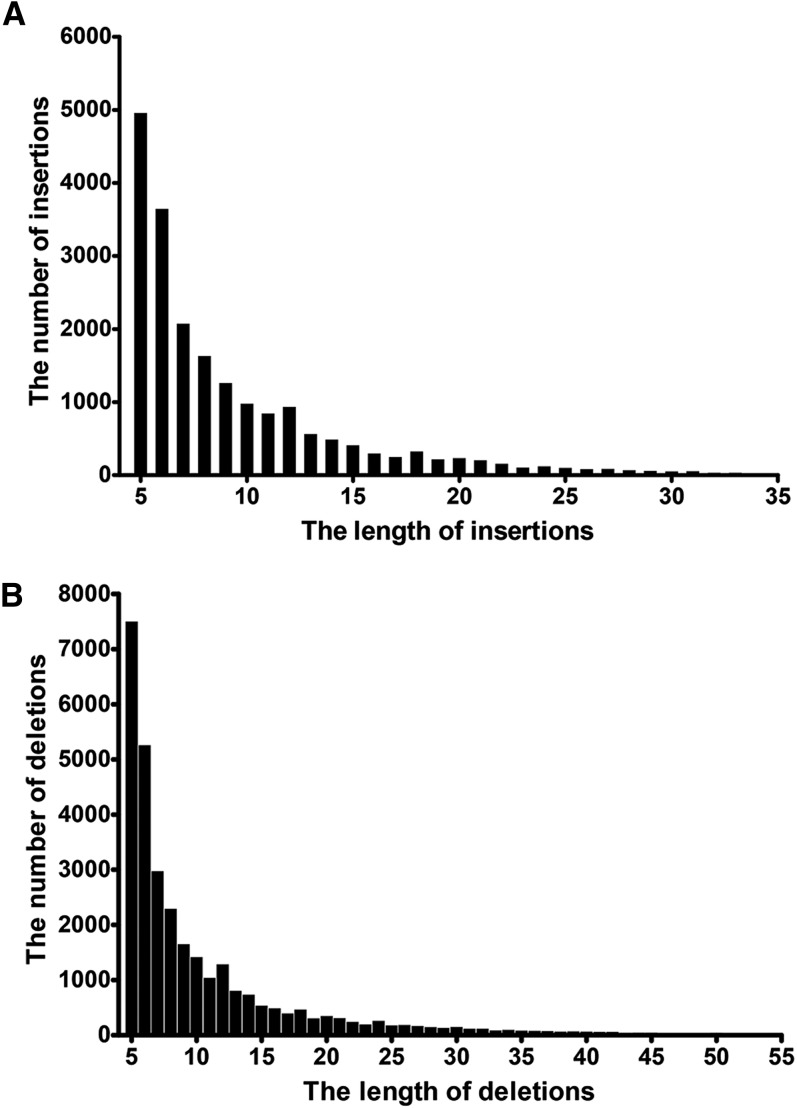
The size distribution of insertions (A) and deletions (B) range from 5 to 55 bp between Williams 82 and Hedou 12. The horizontal axis represents the size of the insertion or deletion. The vertical axis represents the number of insertions or deletions.